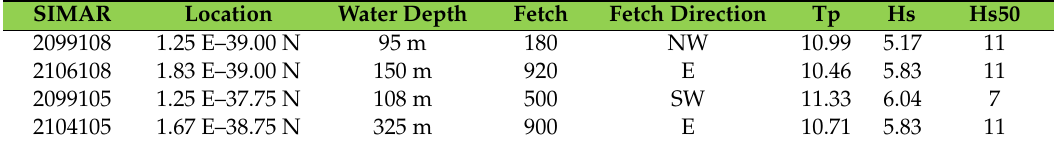
Table 1. Wave data from SIMAR points (Figure 2). Fetch in kilometers; Hs, significant wave height in meters; Tp, wave period in seconds (www.puertos.es); Hs50, significant wave height for 50 years’ return period according to [30] (for location see Figure